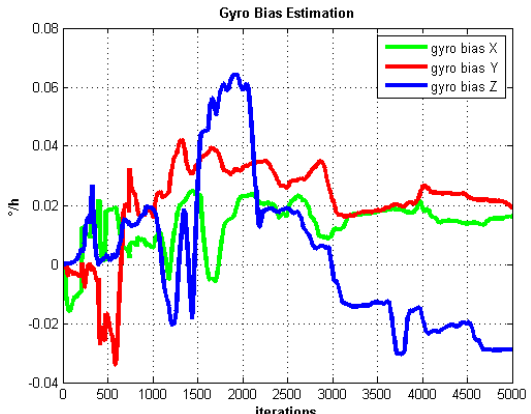
Figure 5. Gyro bias